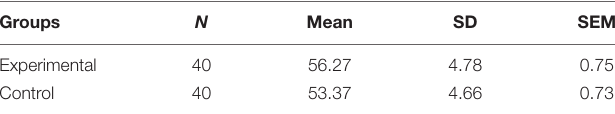
TABLE 1 | Descriptive statistics of both groups in the first administration of the reflective questionnaire. Groups N Mean SD SEM Experimental